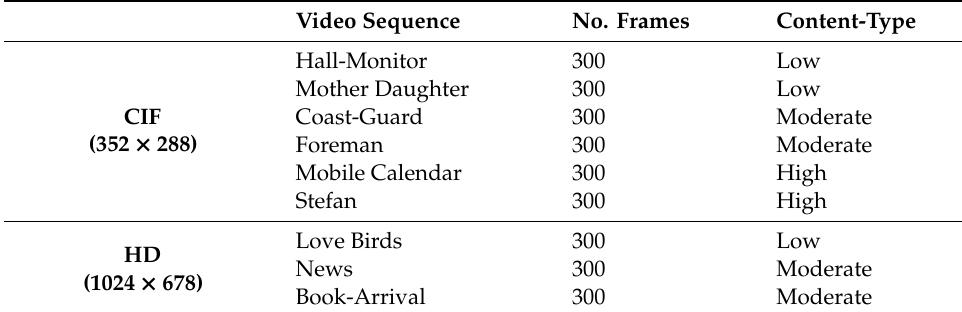
Table 2. Various grayscale CIF and HD standard video